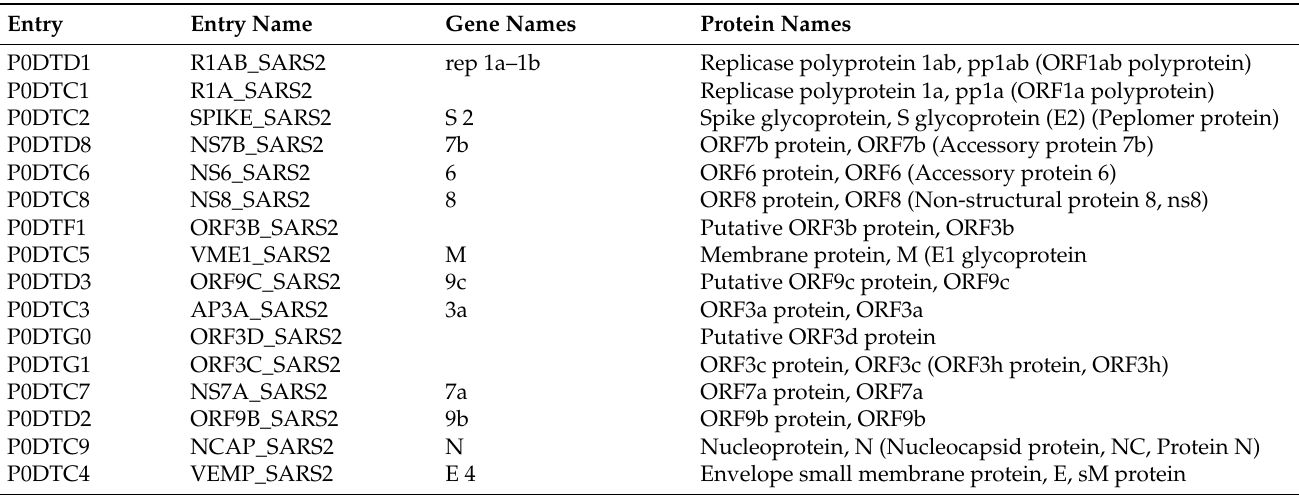
Table 3. Details of nCoV proteins collected from UniProt [106].